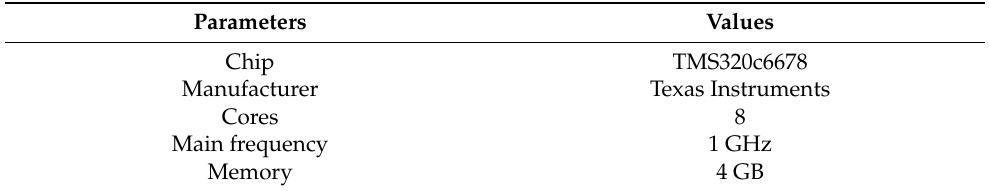
Table 8. Parameters of the field programmable gate array (FPGA). Parameters Values Chip TMS320c6678 Manufacturer Texas Instruments